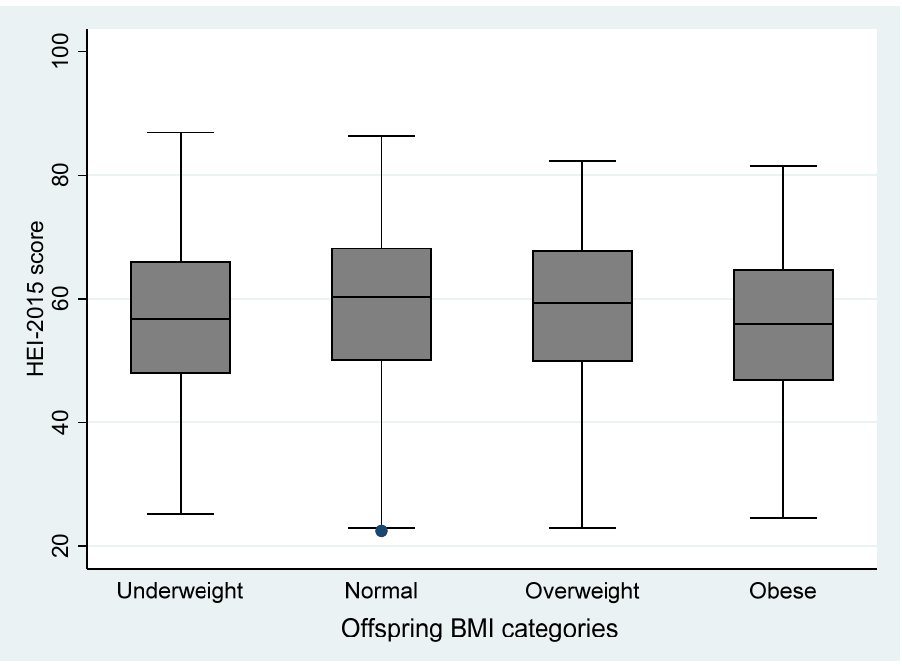
Figure 3. Distribution of pre-pregnancy HEI-2015 score over offspring BMI categories ( n = 3391). Table 2. Maternal characteristics according to HEI-2015 score ( n = 1936 mothers) a . HEI-2015